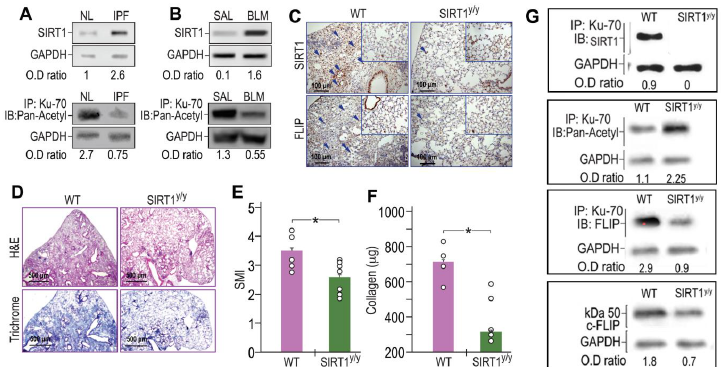
Figure 3. SIRT1 and Ku70-deacetylations increased in human IPF- and in BLM-lung myofibroblasts. Concomitantly, BLM-treated chimeric mice, with SIRT1-deficiency, specifically in myofibroblasts, downregulate FLIP, and show less fibrosis. Fibroblasts were isolated from lungs of patients with IPF- vs. normal subjects, and from BLM- or saline (SAL) - treated mice fourteen days after treatment. ( A , B , upper panels) SIRT1 immunoblot (IB) and ( A , B , lower panels) Ku70 immunoprecipitation (IP) with subsequent pan-acetyl IB ( n = 4). ( C , D ) IHC in lung tissue sections of chimeric, SIRT1 y/y vs. WT, mice, 14 days post BLM (×20 and ×40 inserts, arrows indicate representative stained areas). SIRT1 ( C , upper panels), FLIP ( C , lower panels), H&E ( D , upper panels), and Trichrome ( D , lower panels). ( E ) Graphical presentation of semi-quantitative morphology index (SMI) of H&E stained sections, and ( F ) collagen Sircol assay. ( G ) Fibroblasts isolated from lungs of WT or SIRT1 y/y mice; Ku70 IP with subsequent IB with mAbs for SIRT1, Pan-Acetyl, FLIP, and total lysate IB for FLIP. Representative of two experiments. n = 4–5. * p < 0.05. 3.4. Human IPF-Lung Myofibroblasts Decrease SIRT1 to Normal Levels by a miR-34a Mimic, and Similar to miR-34a Mimic-Treated miR34KO-Murine Lung Myofibroblasts, Decrease Ku70-Deacetylation, Ku70-FLIP